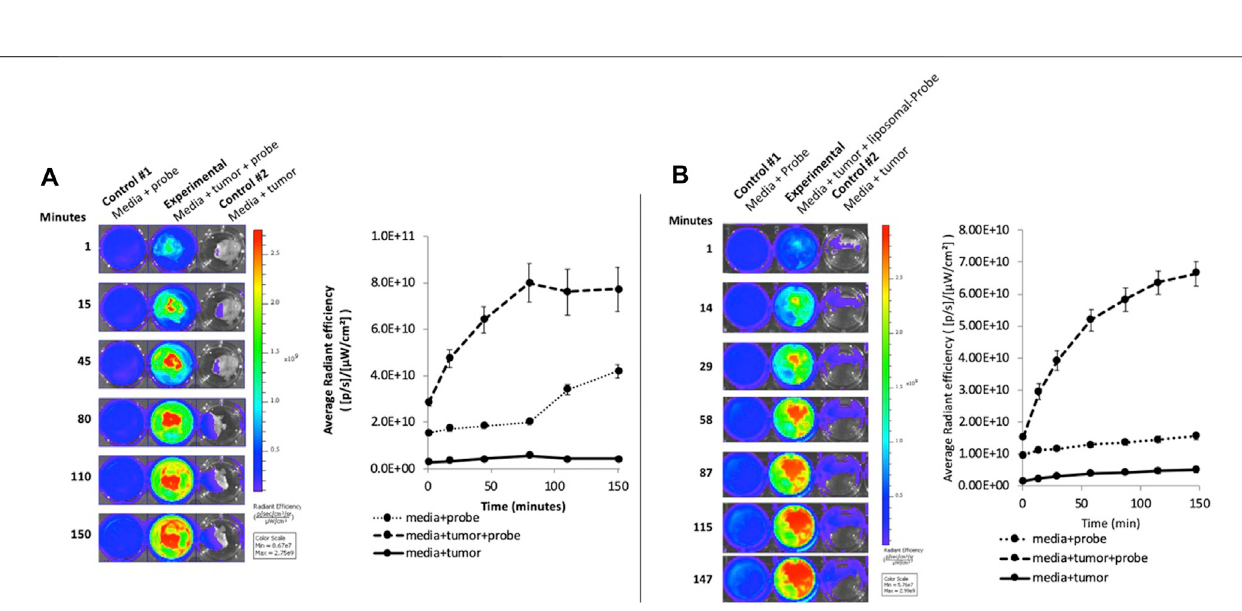
Frontiers in Physics |